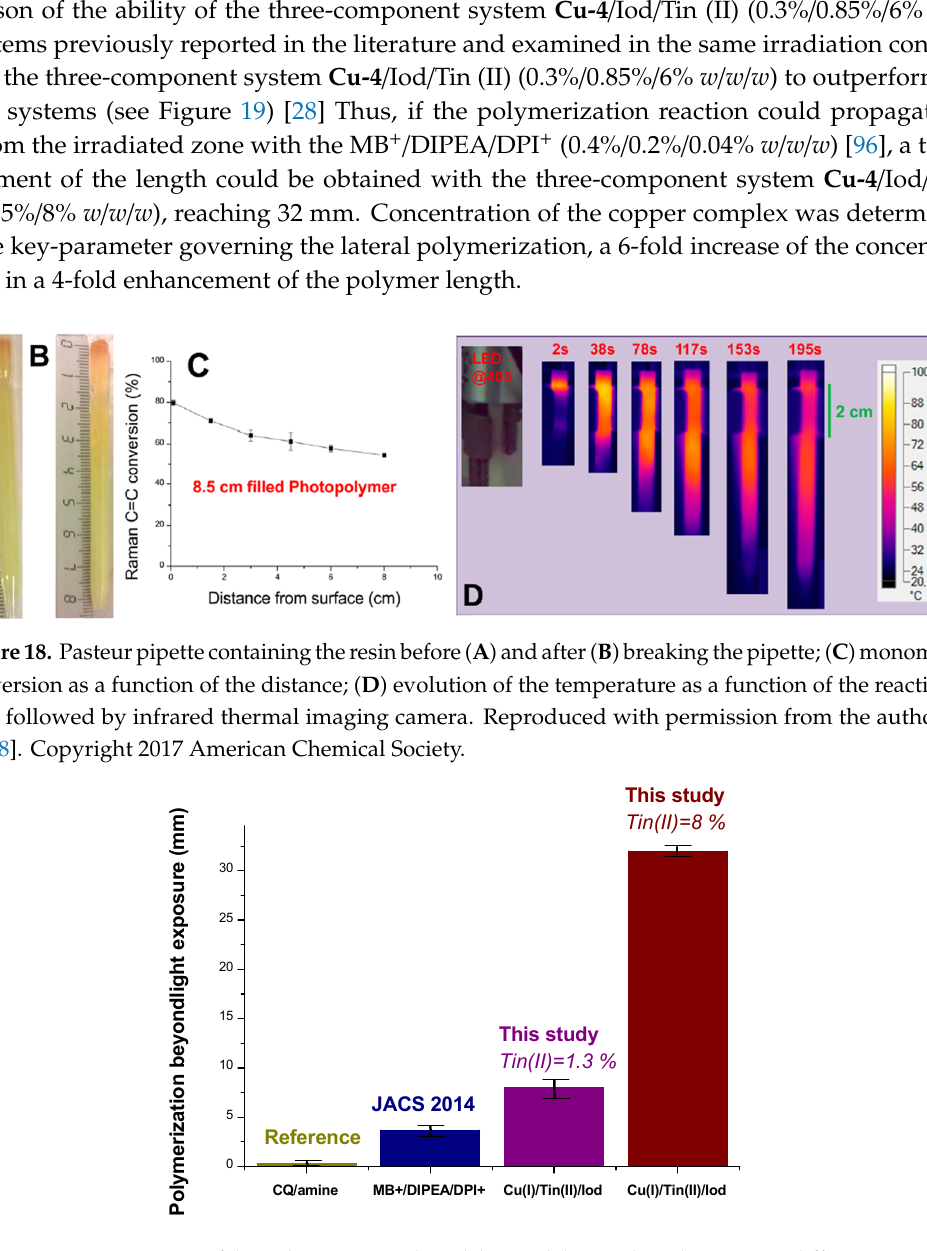
Figure 19. Determination of the polymerization length beyond the irradiated area using different systems previously reported in the literature (camphorquinone/amine: 0.4%/2% w / w and MB + /DIPEA/DPI + : 0.4%/0.2%/0.04% w / w / w ) and Cu (I)/Iod/Tin (II) 0.17%/2%/1.3 w / w / w and Cu (I)/Iod/Tin (II) 0.17%/2%/8 w / w / w examined in this study. Reproduced with permission from the authors of [28]. Copyright 2017 American Chemical Society.